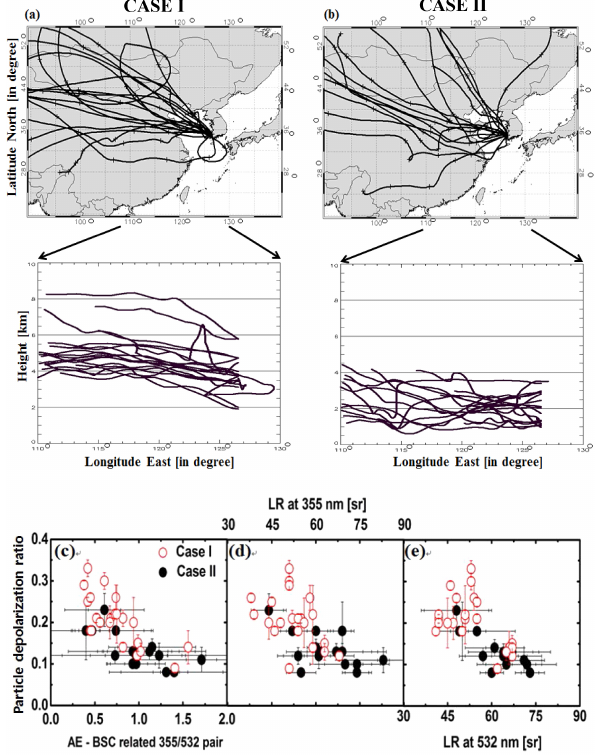
Figure 6. Top panels: transport pattern of the dust plumes that origi- nated in the desert regions and passed over industrialized/populated regions of China before arrival over the Korean peninsula. Middle panels: vertical position of the dust layers during transport: (a) dust layers passed over China at high altitude (case I) (b) dust layers were transported over China through the near surface/lower tropo- sphere (case II). Bottom panels: scatterplot of the linear particle de- polarization at 532nm versus (c) the backscatter-related Ångström exponent (355/532nm wavelength pair), and the (d, e) lidar ratio (at 355nm and at 532nm) with respect to case I and case II. The two categories I and II are denoted by different colors. case I is indicated by red circles. case II is indicated by black